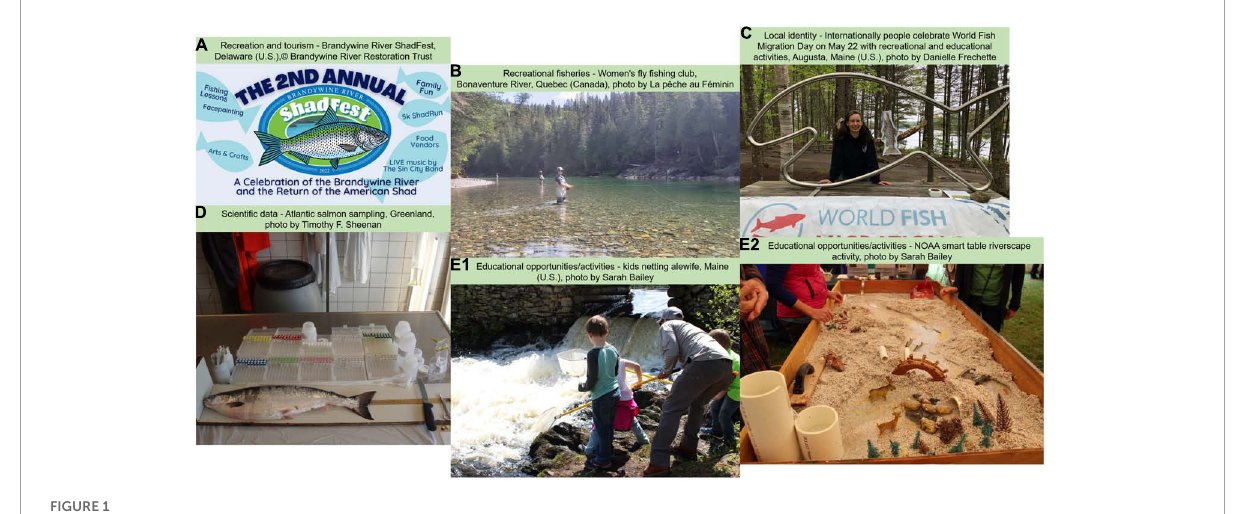
FIGURE1 Visual examples of cultural